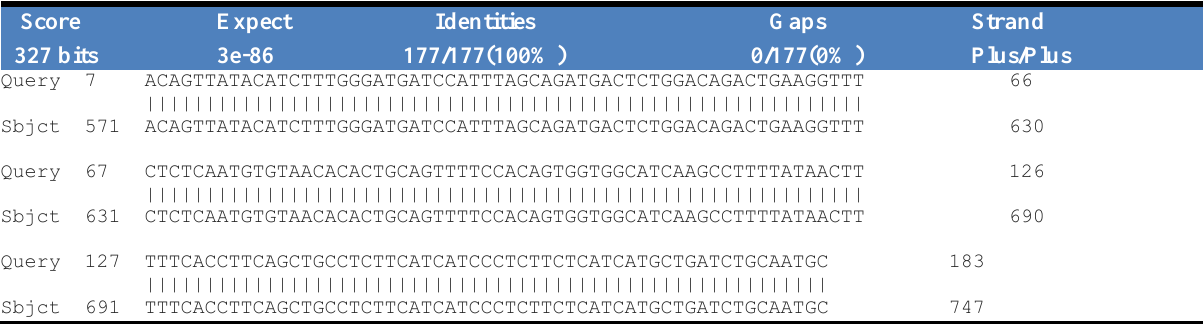
Figure, 2: Sequencing of sense flanking the exon 2 of GnRHR gene, for cases of ewes, obtained from Gene Bank. Query represents of sample; Sbject represent of database of National Center Biotechnology Information (NCBI). Ovisaries gonadotropin releasing hormone receptor (GNRHR), mRNA Sequence ID: